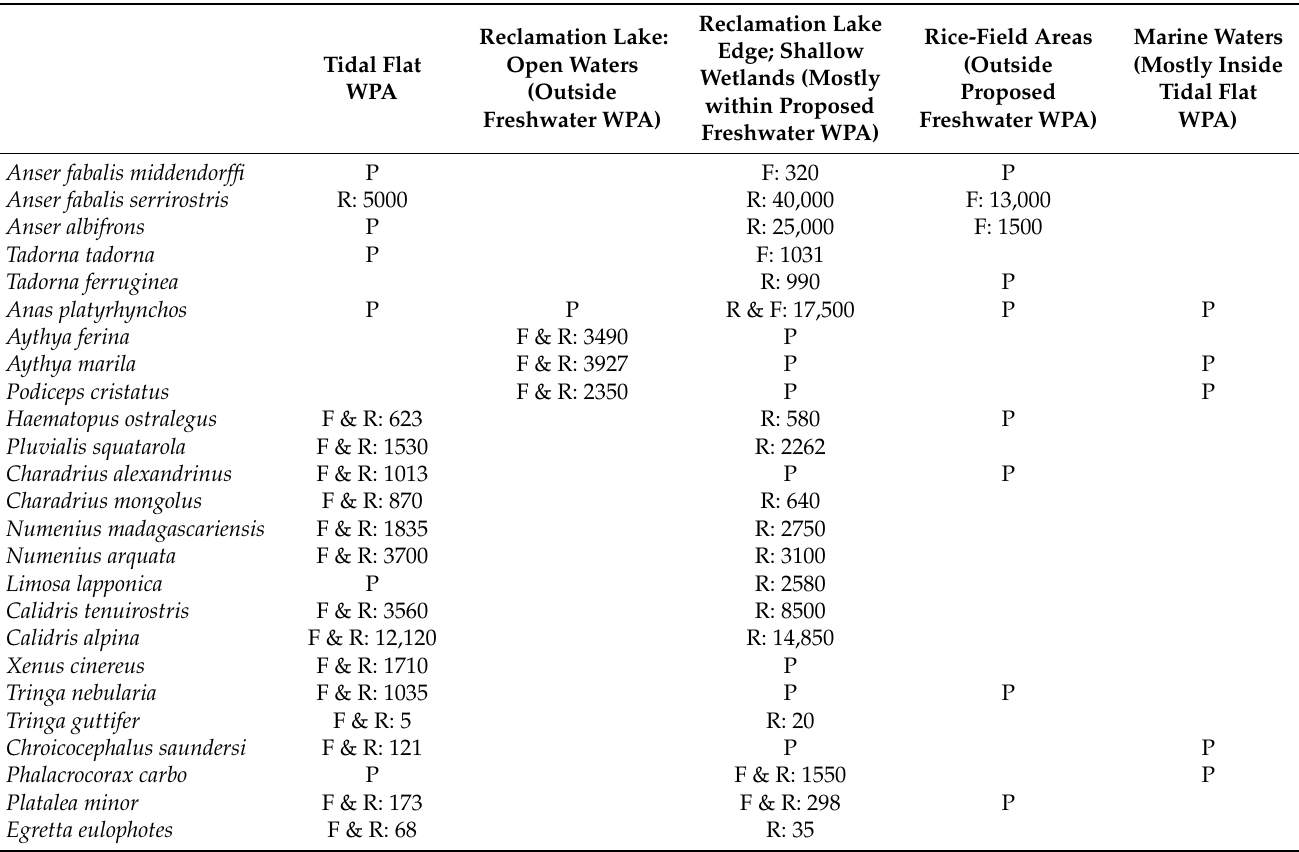
Table 4. Highest counts of internationally important populations and concentrations of Foraging (“F”) and Roosting (“R”) waterbirds in the Hwaseong Wetlands FNS by main wetland habitat during the main and supplementary surveys in 2021 and 2021. “P” indicates presence in concentrations below 1% of a population as assessed by Wetlands International [45].